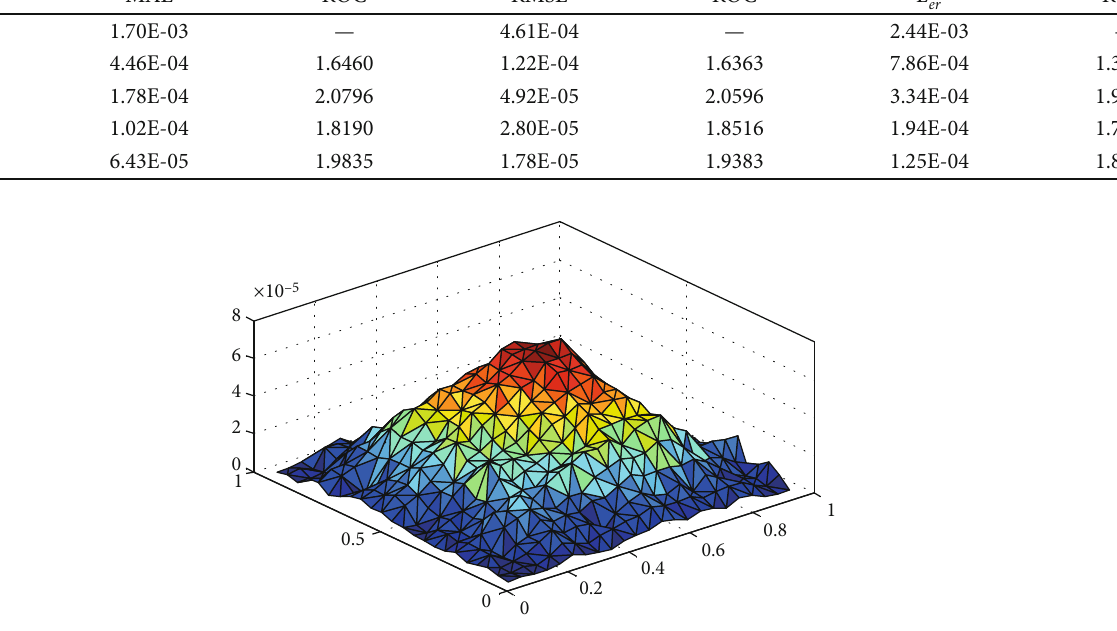
= 25 and ε = 0 : 1 at t = 1 , for Example 4. t